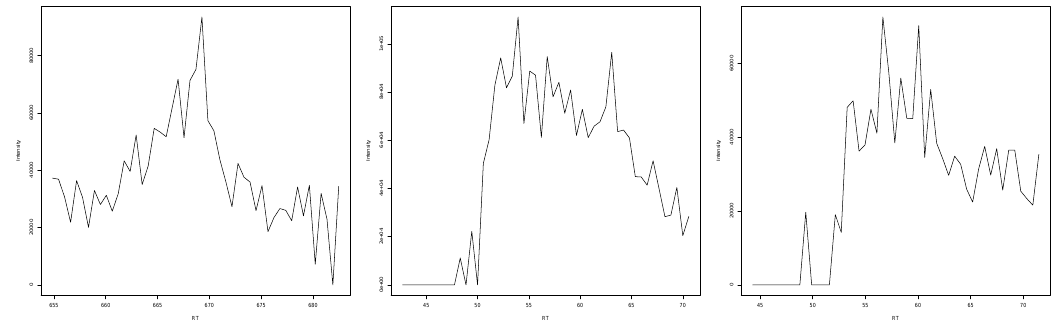
Figure A8. Three examples of EICs where experts either disagreed or were uncertain about them representing a mass spectrometric